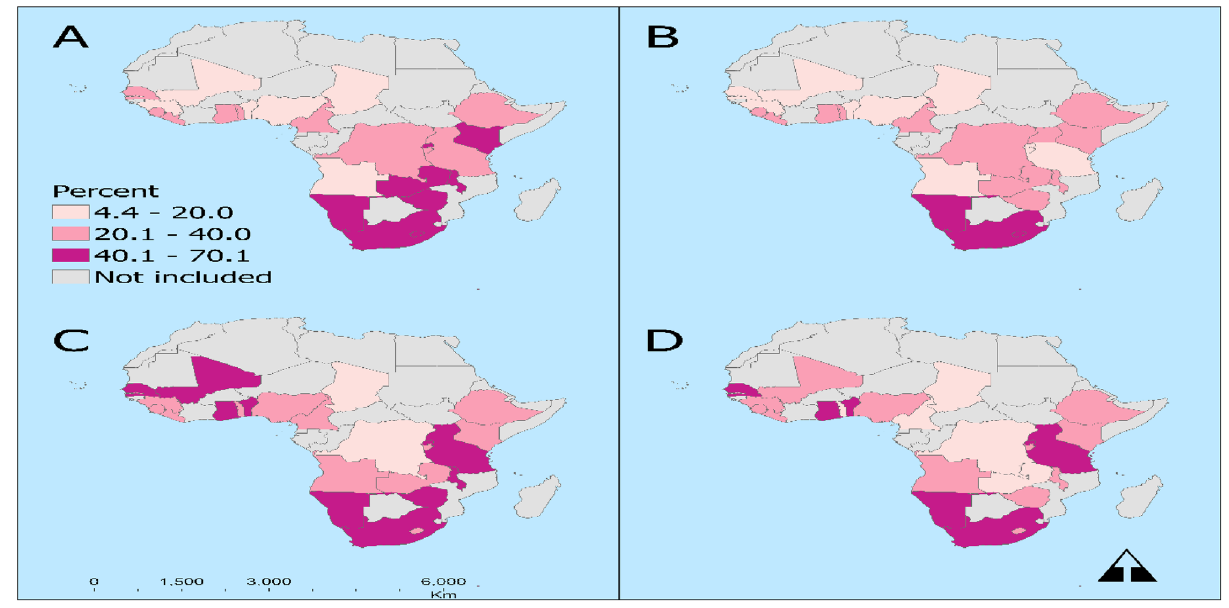
Figure 1. The geospatial distribution of contraceptive use and exposure to FP messages. Prevalence of contraceptive use by ( A ) general population, ( B ) adolescents and the exposure to family planning messages by ( C ) general population, and ( D ) adolescents among women of reproductive age in Sub-Saharan Africa, evidence from DHS